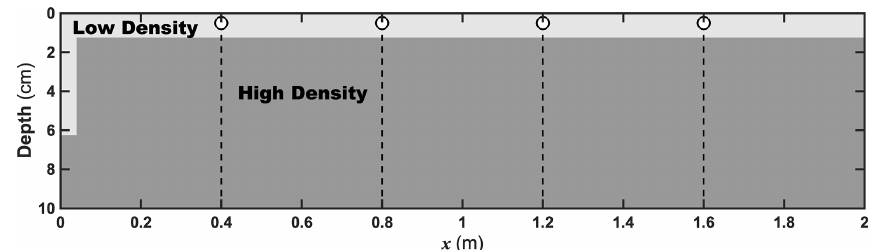
Figure 4. Schematic diagram of the ISW case. The light and dark gray indicate the low- and high-density water with 1003.62 and 1026.95kgm − 3 ; four white dots refer to the high-frequency output